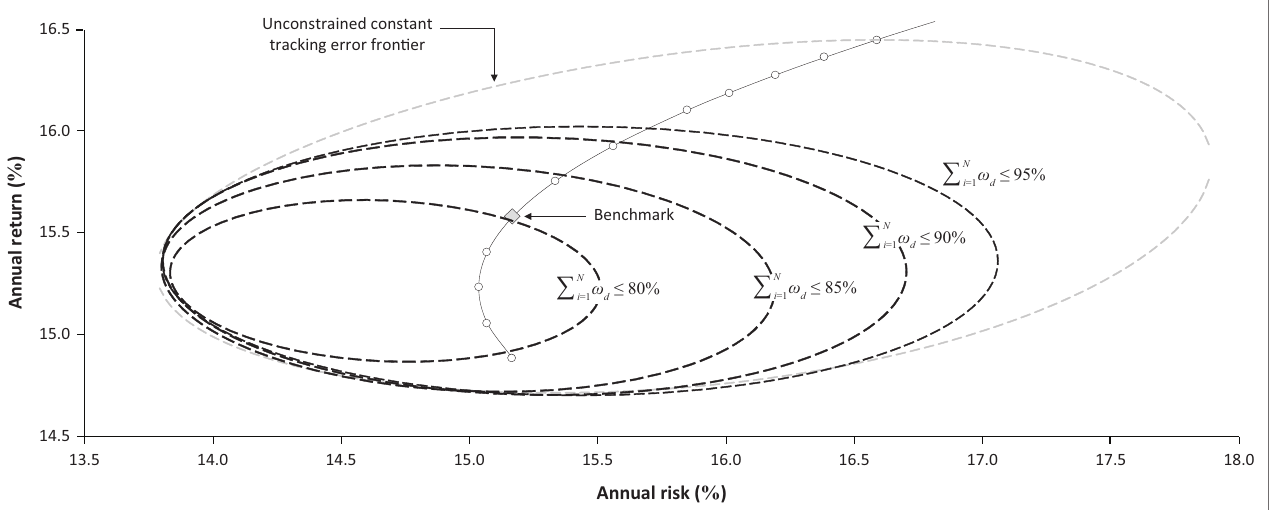
w ≤ 95 % , 90 % , 85 % i di